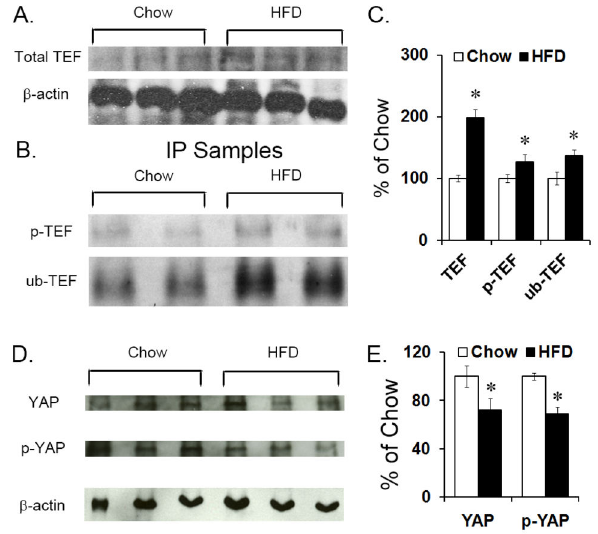
Figure 2. Protein levels in P15 offspring. (A, C) TEF protein level was measured via western blot in the PVN of high-fat diet (HFD) compared to chow P15 offspring, and a statistically significant increase in total TEF was found. (B, C) Further immunoprecipitation (IP) of total TEF protein from the PVN revealed a statistically significant increase in levels of phosphorylated TEF and ubiquitin-tagged TEF. (D, E) YAP protein level was measured via western blot in the PVN of high- fat diet (HFD) compared to chow P15 offspring, and a statistically significant decrease in total YAP and phosphorylated YAP protein was found. Results are expressed as means ± SEM (n = 4) * p < 0.05. The β-actin bands were used to ensure that all samples had the same concentration of protein; they were not used to normalize TEF and YAP bands. The change in TEF and YAP band densities from the HFD group was determined relative to the chow control group. p- TEF = phosphorylated TEF; ub-TEF = ubiquitin-tagged TEF.